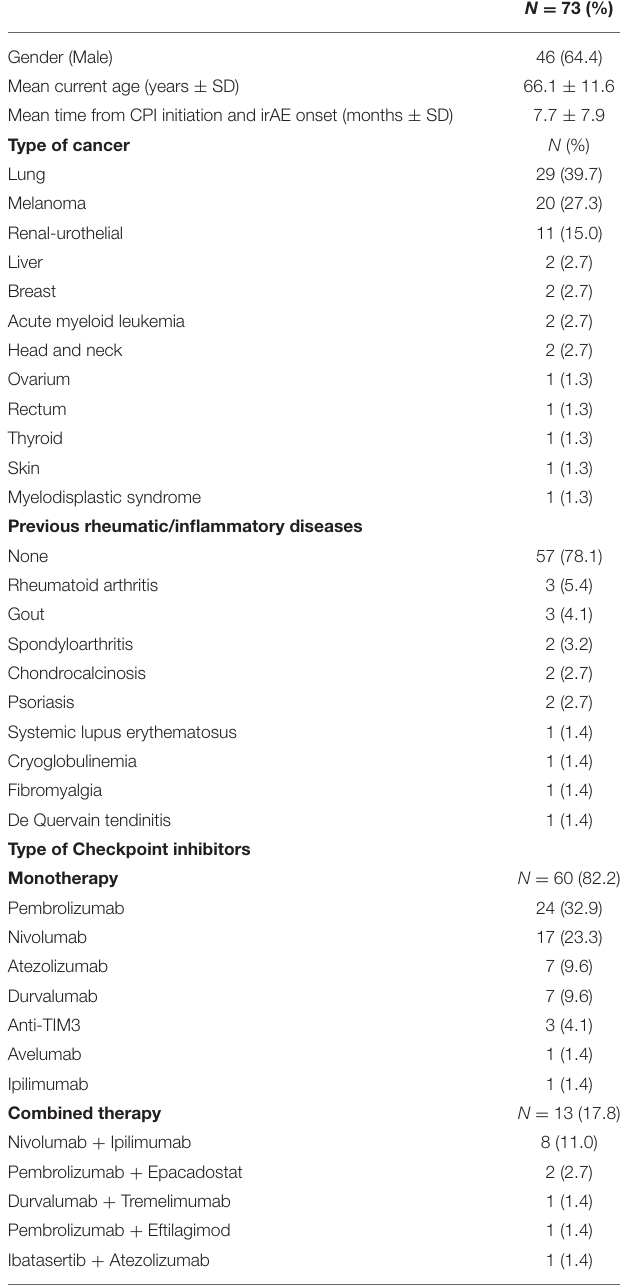
TABLE 1 | General characteristics, type of cancer and ICI